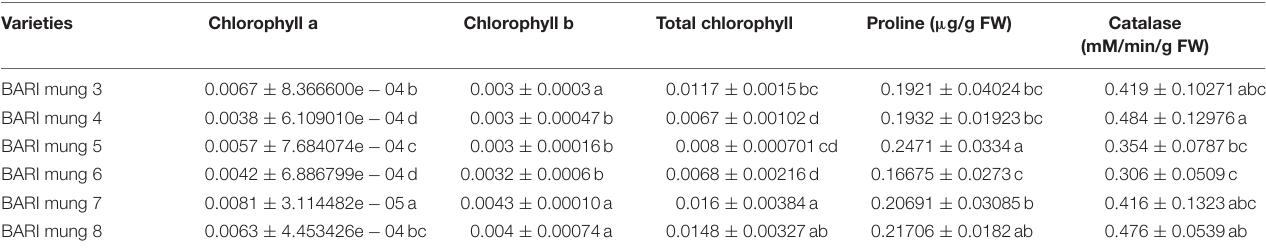
TABLE 6 | Mean comparison of antioxidants activities at back ground soils (0.078 mg kg − 1 arsenic) of different mung bean genotypes.